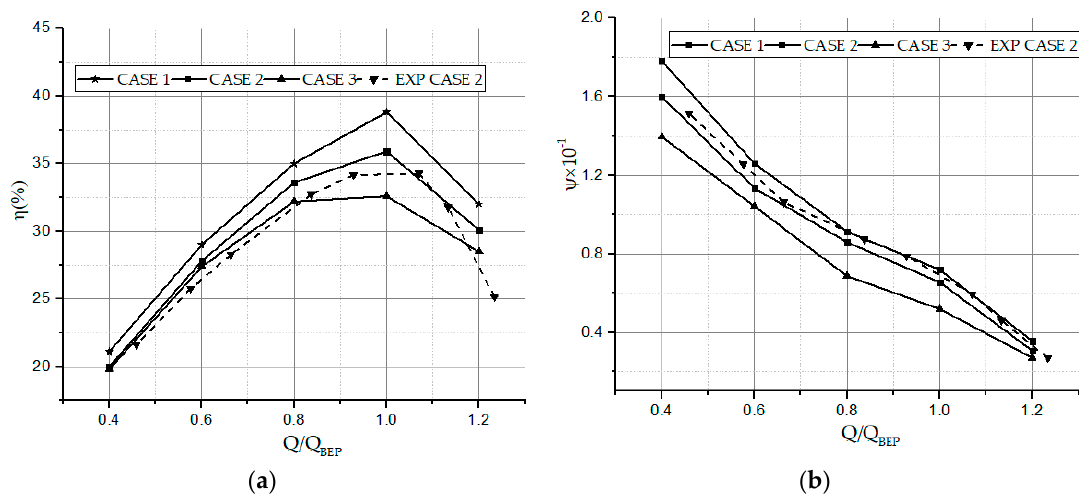
Figure 15. Hydraulic performance curves comparison with CFD data ( a ) efficiency ( b ) head coefficient.